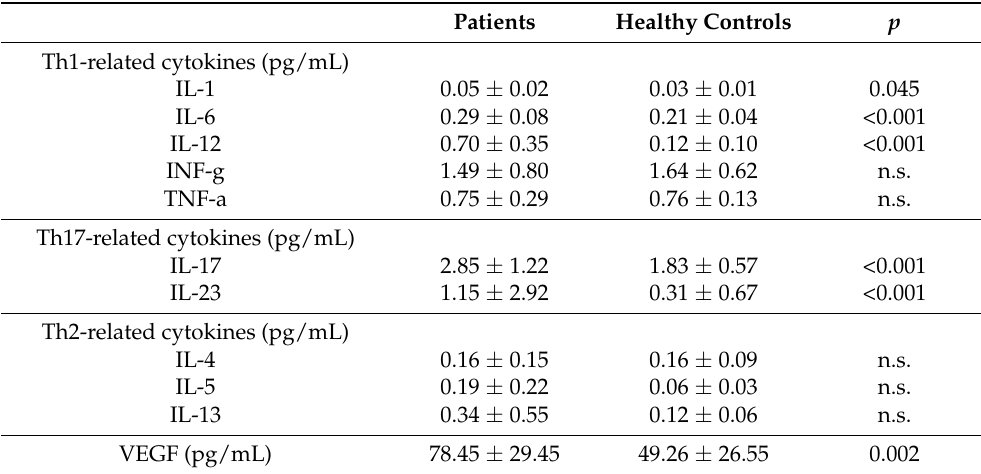
Table 2. Comparison of EBC cytokines in patients and healthy controls.